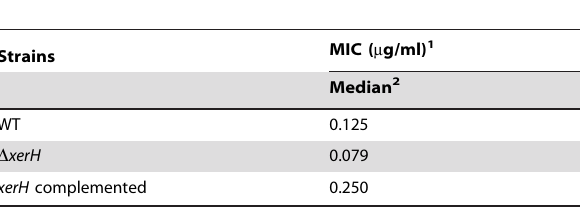
Table 3. Ciprofloxacin susceptibility of H. pylori strains.